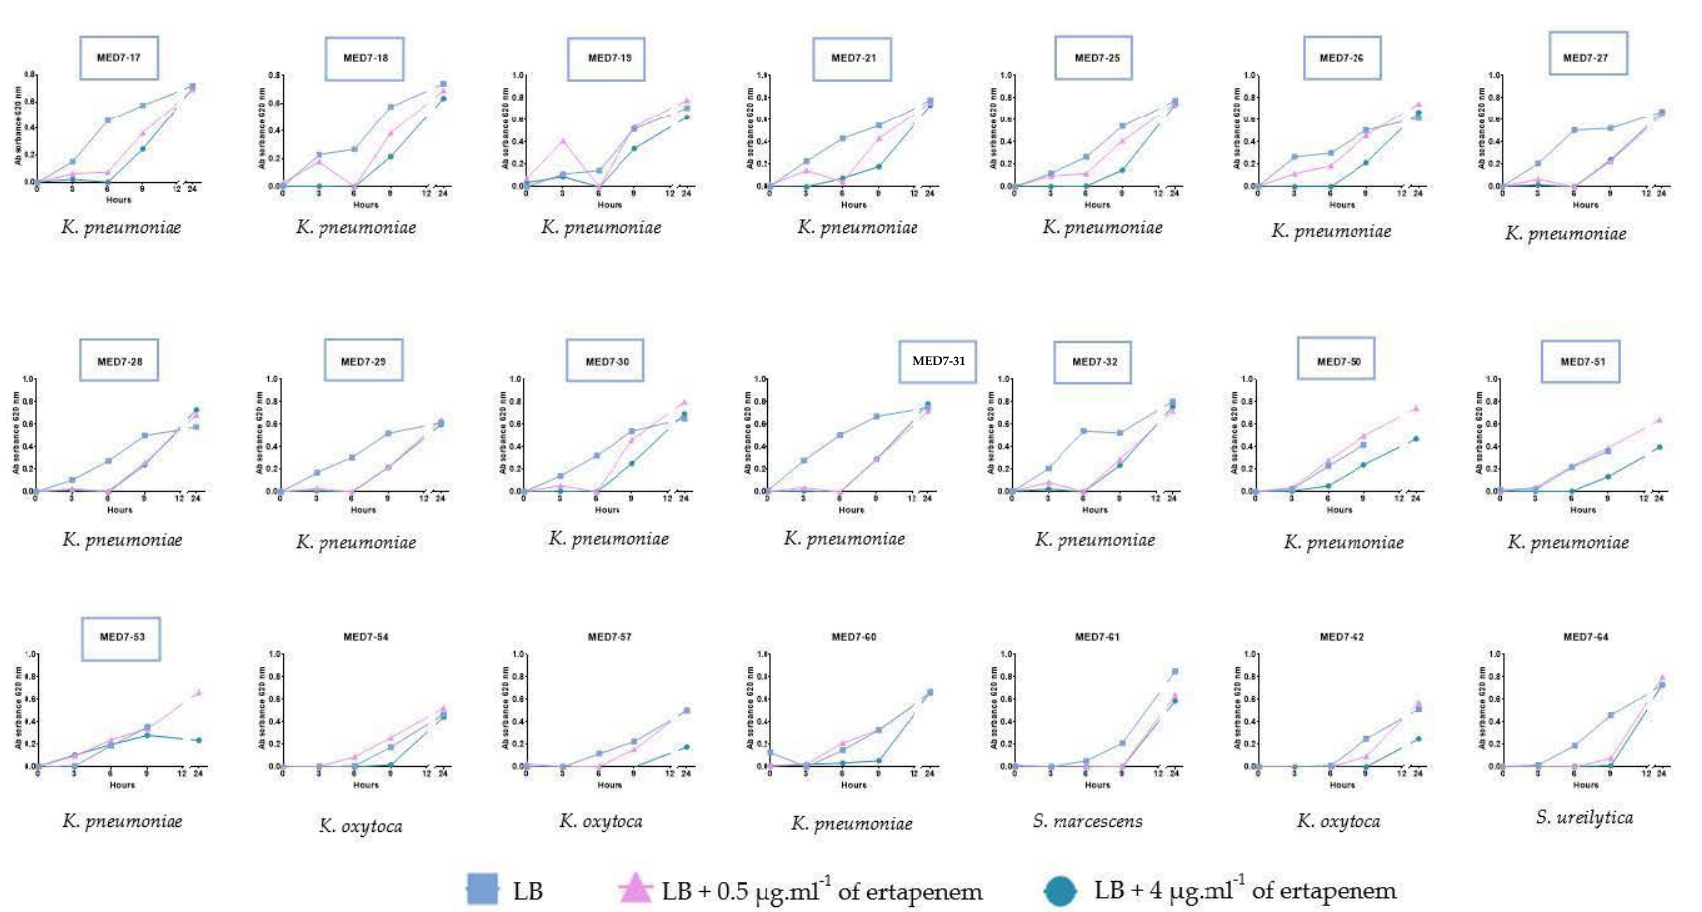
Figure 3. Growth over time according to the ertapenem concentration (0, 0.5 or 4 µ g · mL − 1 ) and species identification of presumptive carbapenemase-producing carbapenem-resistant-Enterobacterales isolated from MED7. Presumptive CP-CRE after nine hours of incubation are framed.